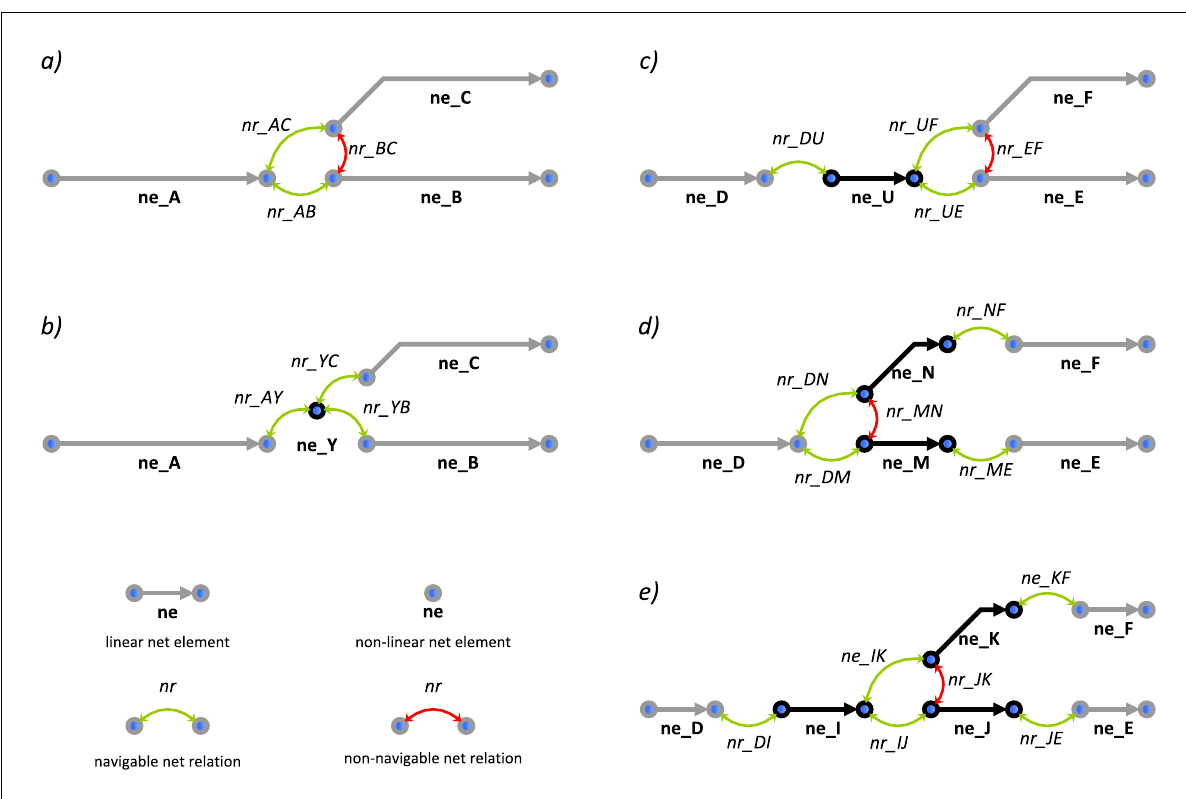
Figure 5. Possible expressions of an ordinary turnout using net elements and net